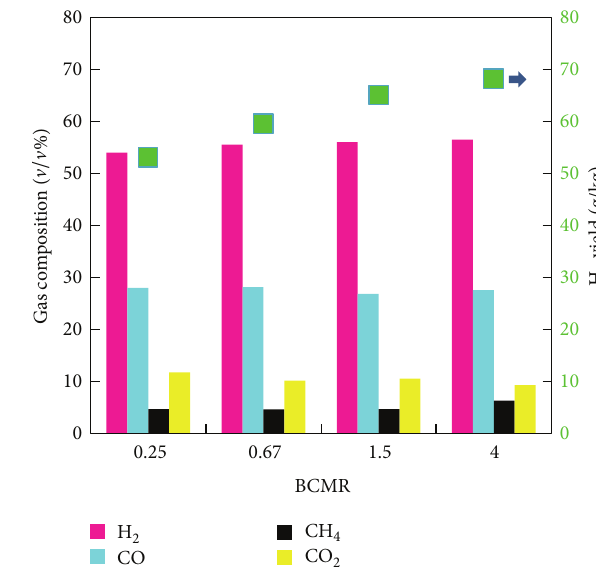
Figure 3: Influence of SBMR on H 2 -rich gas production.